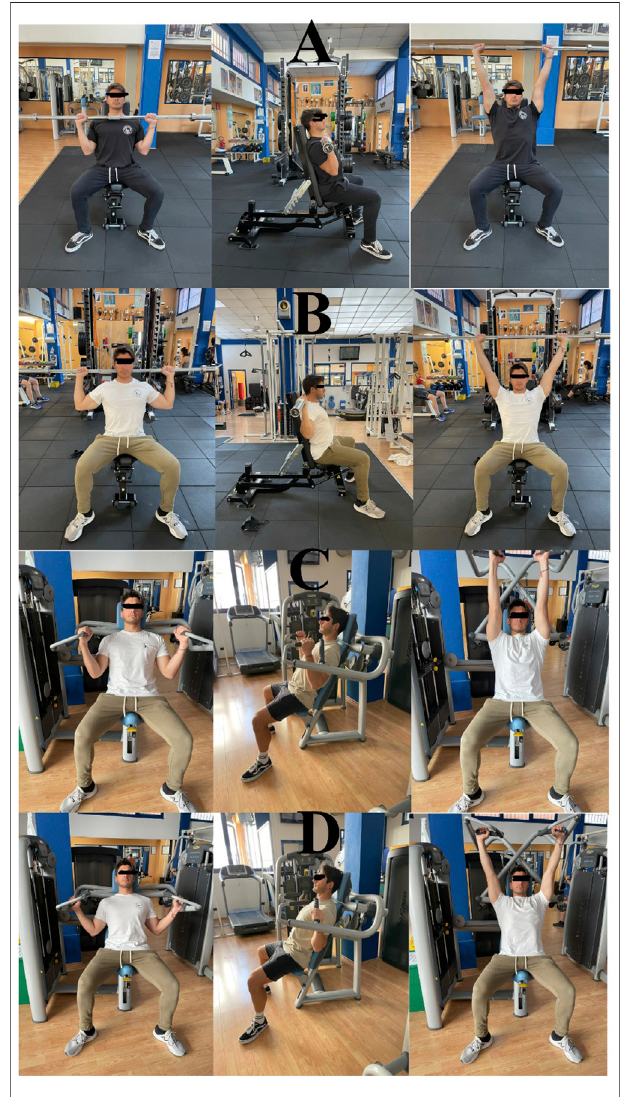
FIGURE 1 | The technique for each exercise, described with a frontal andlateralviewofthestartandafrontalviewoftheendofeachmovement: (A) front barbell military press; (B) back barbell military press; (C) front machine shoulder press; (D) back machine shoulder